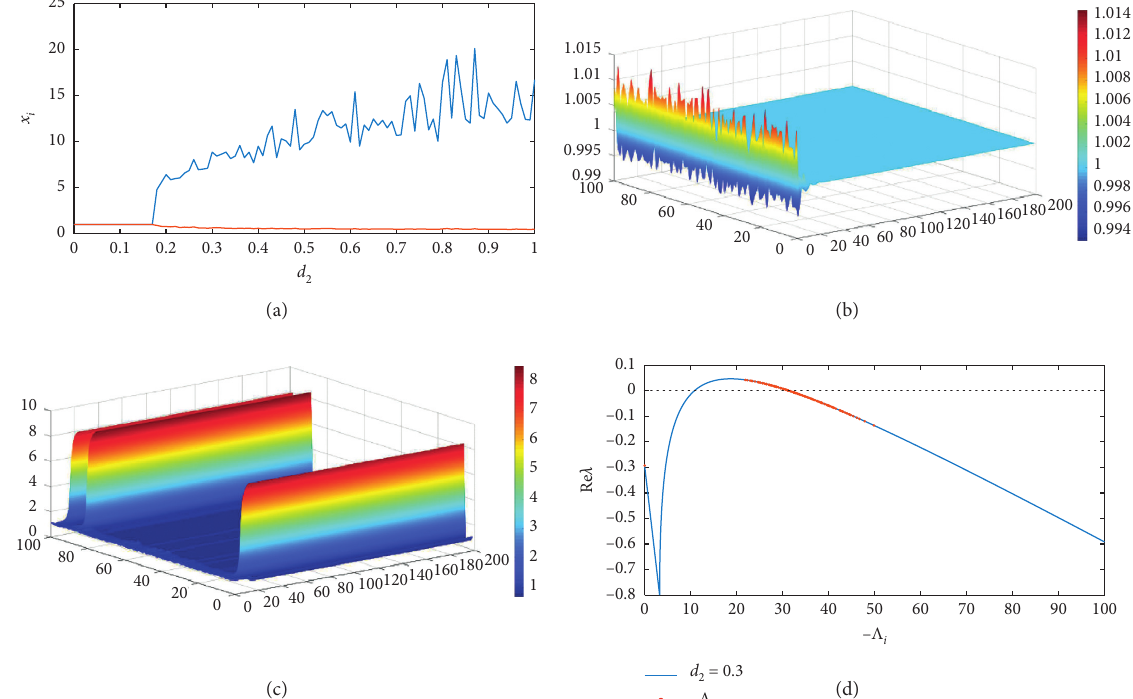
Figure 10: (a) The bifurcation diagram of d � 0 . 1. (c) Turing instability occurs when d when d 2